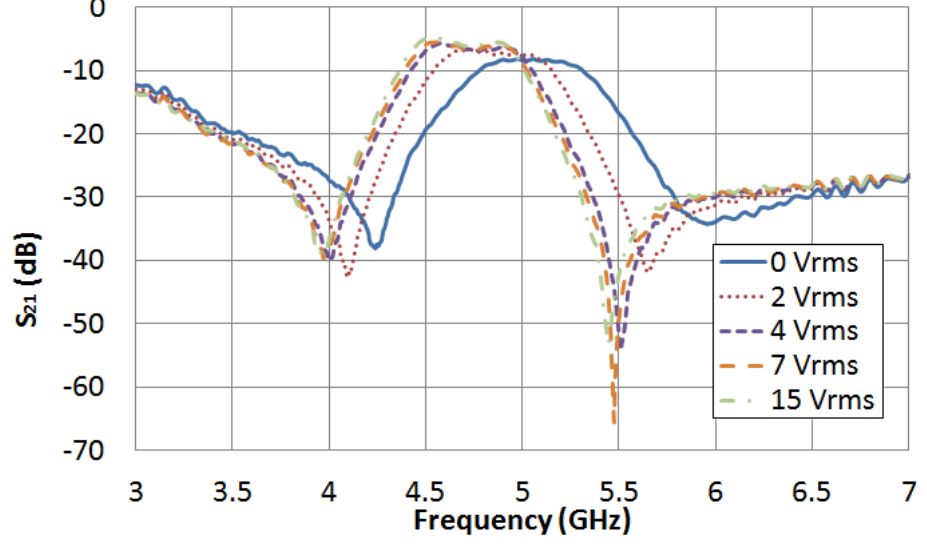
parameter for the new bandpass filter. 21